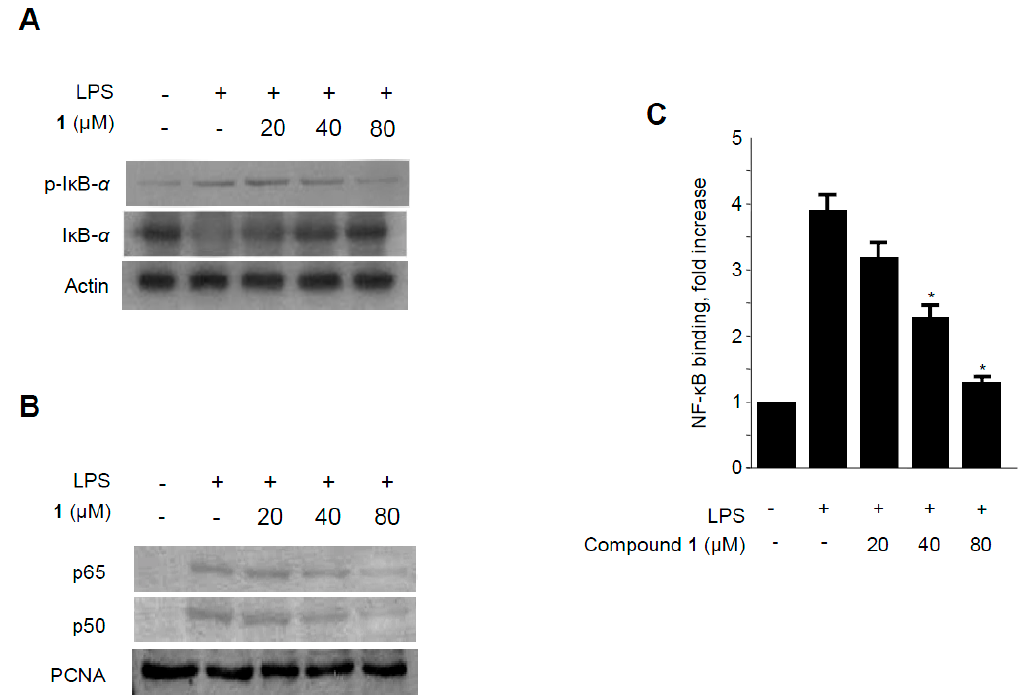
Figure 8. Effects of methylpenicinoline ( 1 ) on LPS-induced NF- κ B activation in